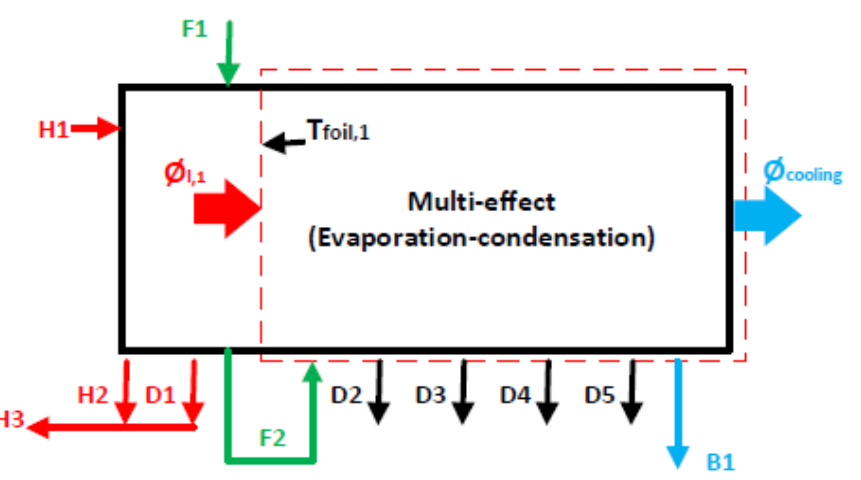
Figure 4. Conceptual scheme for the determination of the exergetic efficiency.